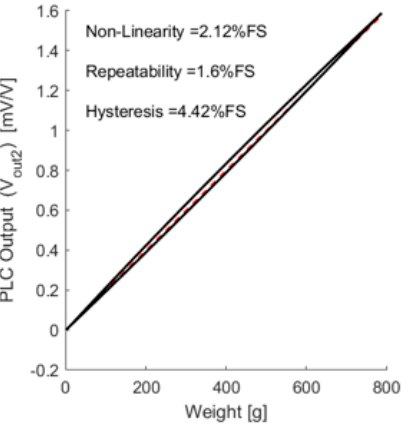
Figure 12. PLC performance non-compensated characterization.